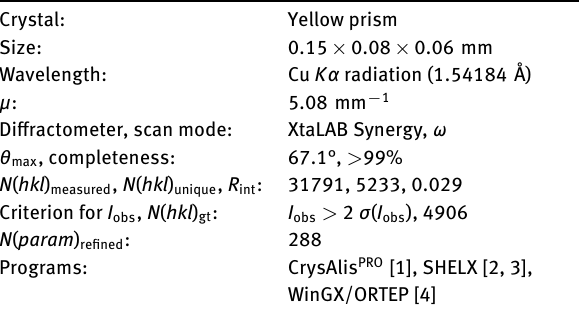
Table 1: Data collection and